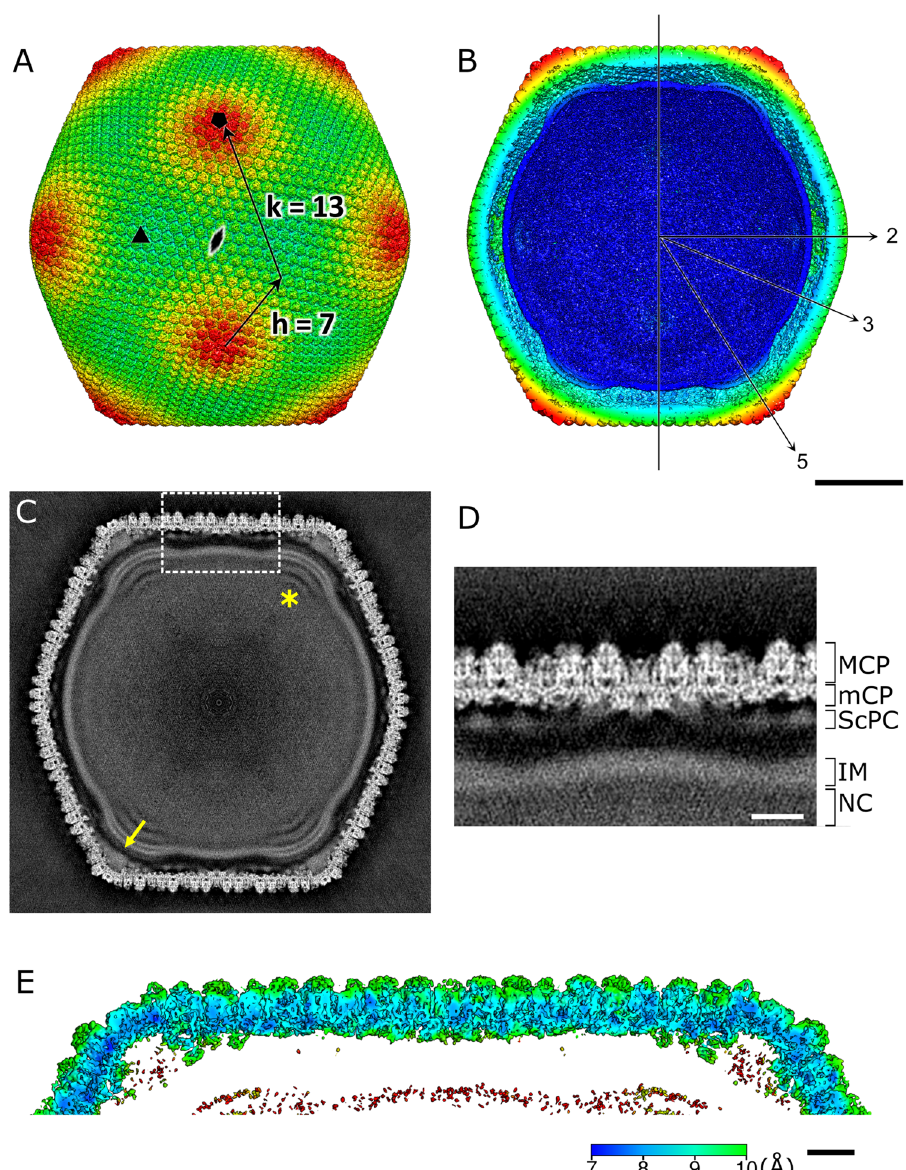
Figure 3. SPA 3D reconstruction of tokyovirus at 7.7 Å resolution. ( A ) An isosurface view, coloured by radius, and showing the fivefold (black pentagon), threefold (black triangle) and twofold (black double-teardrop) symmetry axes. H, K indexes indicating the T = 309 icosahedron are included. ( B ) A cross-section view, with symmetry axes shown with arrows. ( A , B ) are coloured by radius in UCSF Chimera with the following parameters: blue, 910 Å; turquoise, 1010 Å; green, 1080 Å; yellow, 1125 Å; red, 1200 Å and are shown at 2 σ. ( C ) A central slice of the 3D reconstruction. Asterisk shows a multilayer structure in the extrusion of the internal membrane. Arrow indicates weak densities connecting the vertex of the capsid and the internal membrane extrusion. ( D ) Focussed view of the marked box in ( C ), showing delineation between major capsid protein (MCP), minor capsid protein (mCP), scaffold protein component (ScPC), internal membrane (IM), and nucleocapsid (NC). ( E ) local resolution of the capsid, estimated by the blocres module of Bsoft 71 , focussing on the upper capsid edge, sliced to permit visualisation of internal density and is shown at 3 σ. Scale bars: ( A – C ) 50 nm, ( D , E ) 10